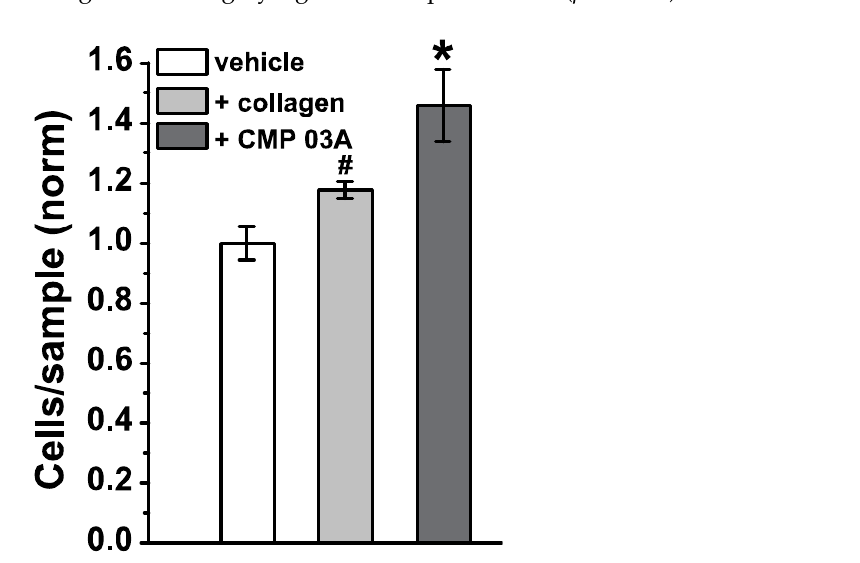
Figure 4. Quantification of ARPE-19 cell migration. ARPE-19 cells adhering to the basal side of transwell membranes which were pre-coated with either vehicle (DDW), intact human type I collagen, or CMP 03A (100 µM) following application of cells to the apical side. Normalized relative to vehicle, CMP 03A promoted migration and adherence significantly better than both vehicle and collagen (*, p < 0.001), while collagen was significantly more efficacious than vehicle (#, p = 032). Data = mean ± SEM ( n ≥ 6 samples for each condition).